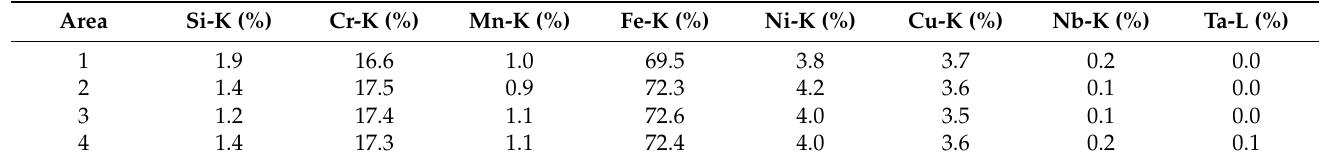
Table 1. The chemical composition of DMLS sintered parts (areas are shown in Figure 5).